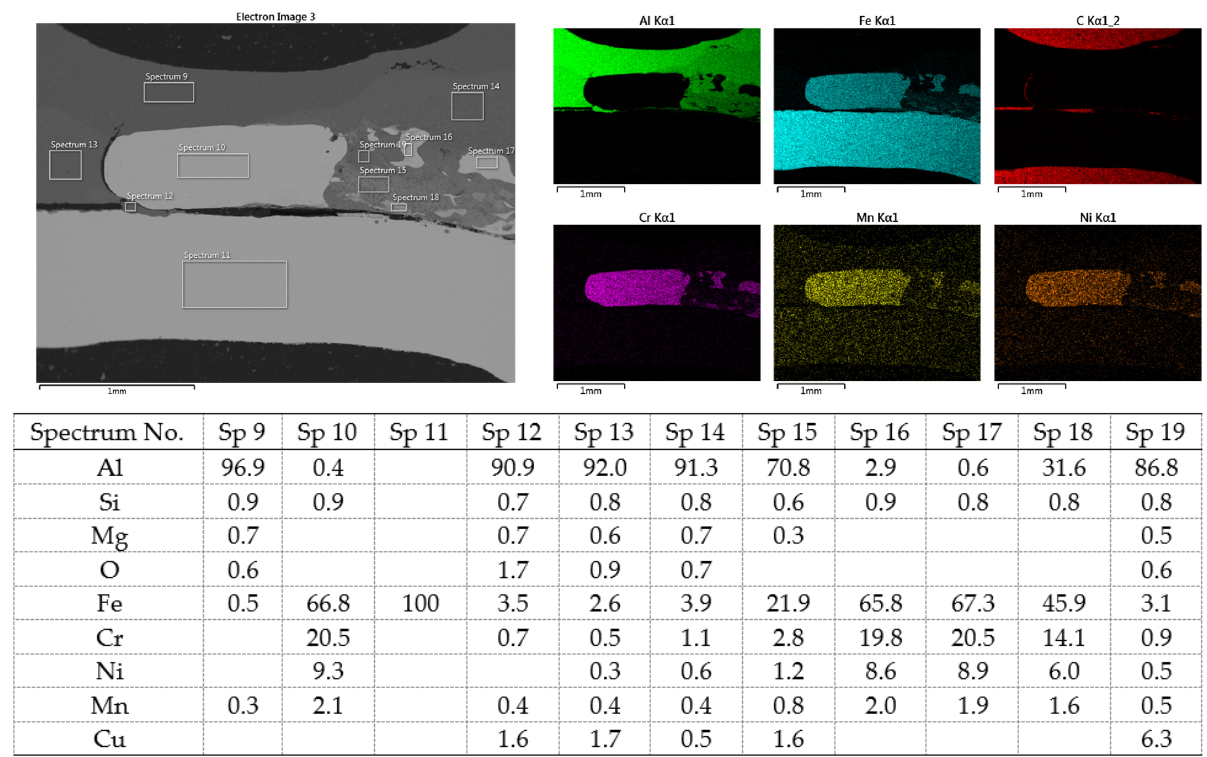
change in Al and Fe contents at the joint interface (see Al and Fe elemental distribution Figure 20. SEM analysis of Al-DC connection, distribution element maps and EDX spectra. map). The metallographic section of the intact joint showed the insert element (spectra 10, 16 and 17) sealed in the Al sheet. Spectrum 9 confirms the basic chemical composition of the Al sheet, and spectrum 11 confirms the basic chemistry of deep-drawn low-carbon DC steel. The other spectra span different phases at the Fe-Al interface, ranging from the more aluminum-rich phases located farther away from the steel (spectra 13 and 14) to the more iron-rich phases lying close to the steel (spectra 15 and 18). The SEM analysis of the joint detail at the DC-Al–insert-element interface (Figure 21) more clearly shows this gradient